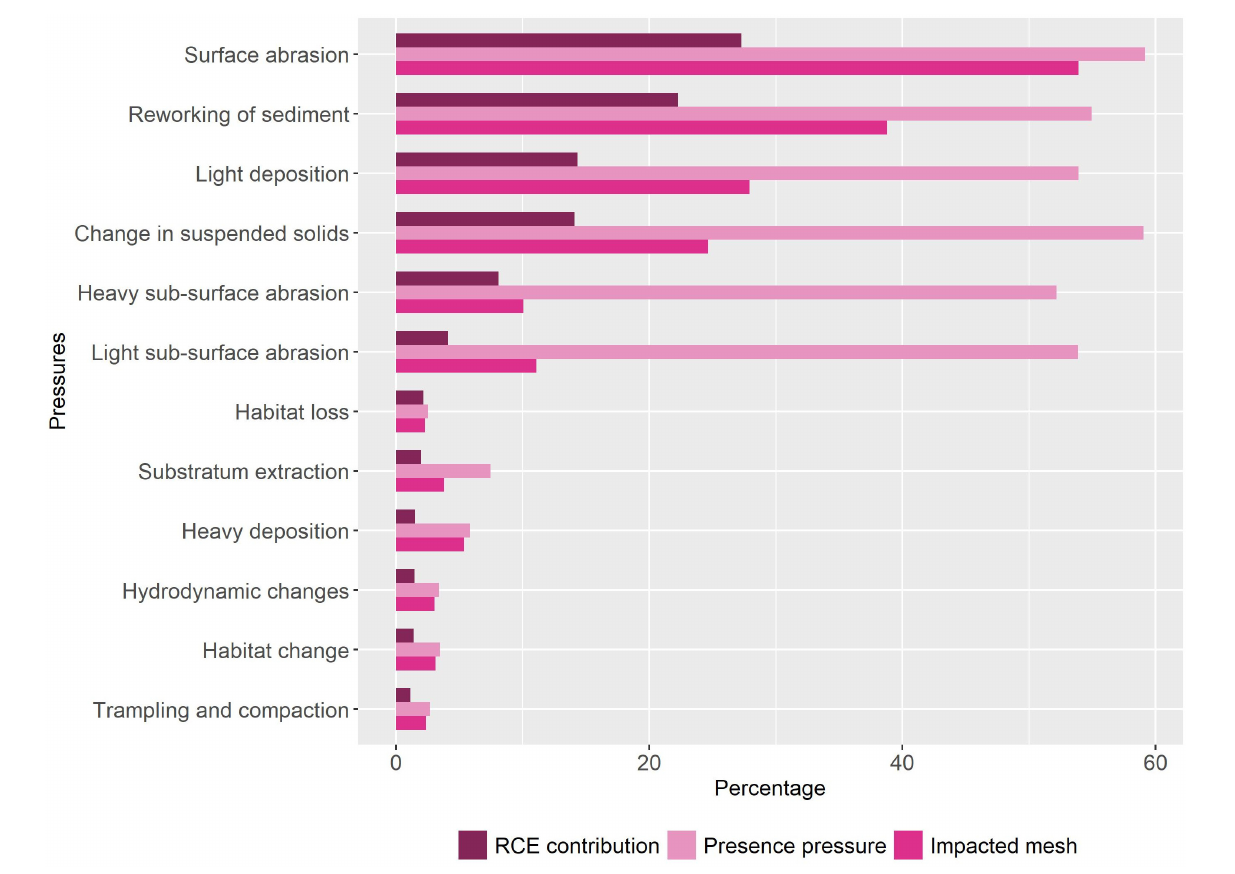
FIGURE 8 | Contribution of pressures to the RCE. “Pressure presence” represents the percentage of grid cells where the activity is located; “impacted mesh” represents the percentage of grid cells where the activity contributes to the RCE; “contribution to RCE” represents the contribution of the activity to the total RCE in the studied area, in